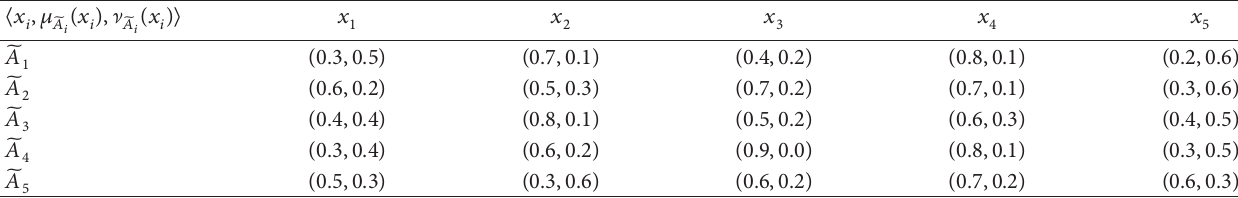
Table 1: The conditions of five patients.